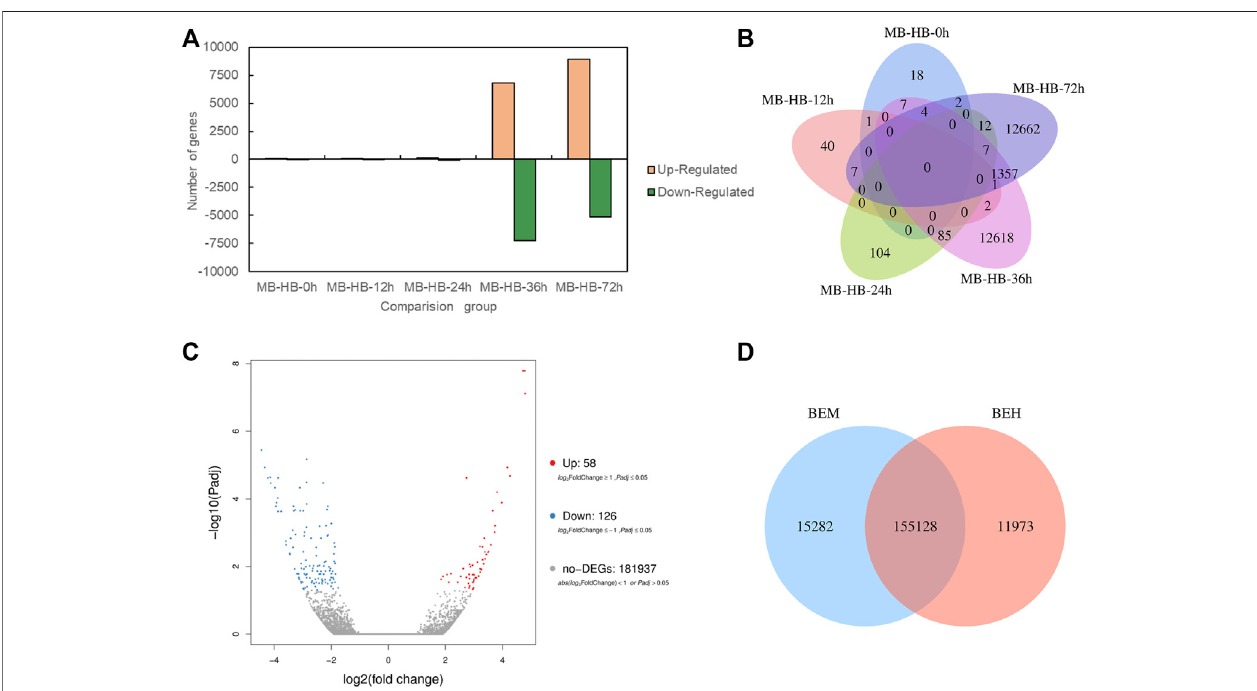
FIGURE 2 | Differentially expressed genes statistics between melatonin treatment group and control group. (A) Upregulated and down regulated DEGs ( p adj < 0.05) statistics of MB group vs. HB group at fi ve points in time after inoculation. MB represents plants were pre-treatment with melatonin and then inoculated with B. elliptica ; HB represents plants were pre-treatment with Milli-Q water [ethanol/water (v/v) D 1/10,000], and then inoculated with B. elliptica. (B) Venn diagram of the number of DEGs ( p adj < 0.05) between MB group vs. HB group. MB represents plants were pre-treatment withmelatonin and then inoculated with B. elliptica ; HB represents plants were pre-treatment with Milli-Q water [ethanol/water (v/v) D 1/10,000], and then inoculated with B. elliptica. (C) Volcano plot of DEGs ( p adj < 0.05) between the comparison BEM vs. BEH, BEM representsplants were inoculated with B. elliptica for 36 h and then treated with 100 ml melatonin (2 mM/L) for 36 h; BEH representsplantswereinoculatedwith B.elliptica for36 handthentreatedwith100 mlMilli-Qwater[ethanol/water(v/v).D1/10,000]for36 h. (D) Venndiagramillustrate the number ofDEGs ( p adj < 0.05) between the comparison BEM vs. BEH, BEM represents plants were inoculated with B. elliptica for 36 h and then treated with 100 ml melatonin (2 mM/L) for 36 h; BEH represents plants were inoculated with B. elliptica 36 h and then treated with 100 ml Milli-Q water [ethanol/water (v/v) D 1/10,000] for 36